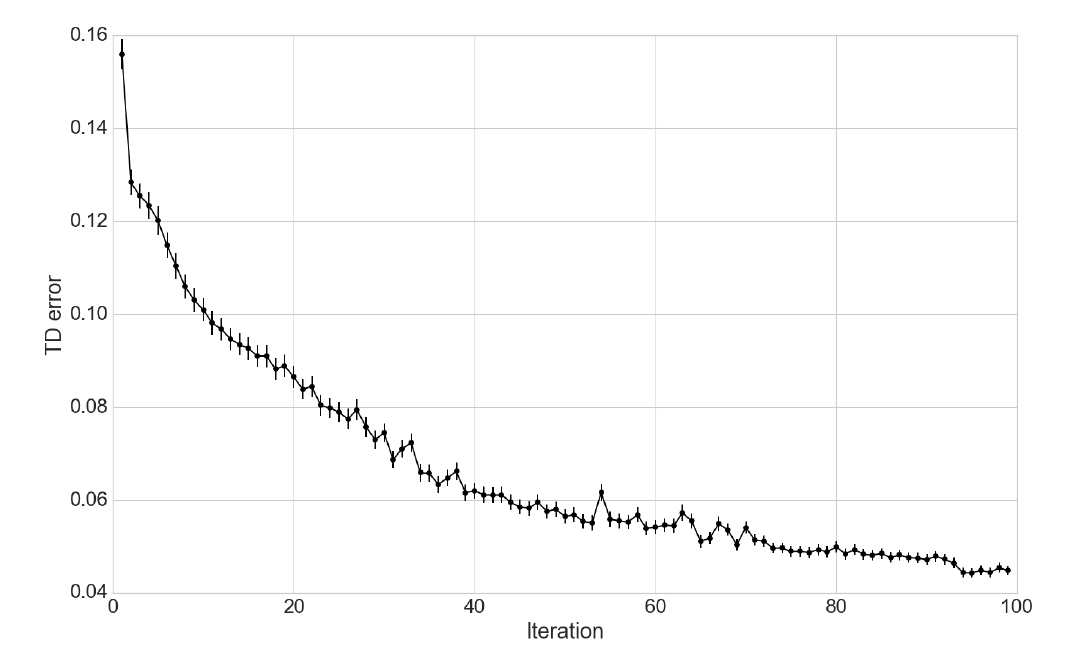
Figure 3. Learning convergence of the temporal difference (TD)